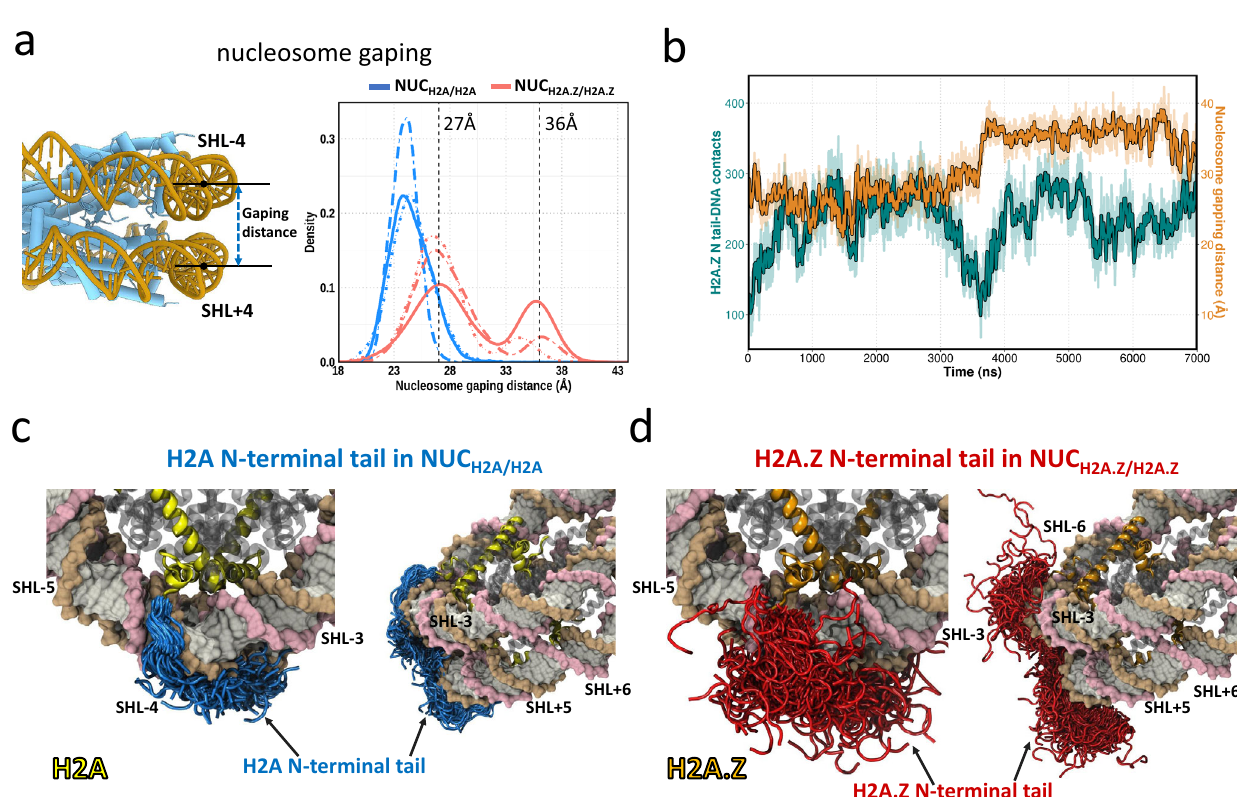
Fig.4|H2A.ZN-terminaltailmodulatesnucleosomegapping.a Distributionsof nucleosome gaping distances in NUC H2A/H2A (blue) and NUC H2A.Z/H2A.Z (red) sys- tems from three independent simulation runs (solid, dotted and dashed lines). Vertical dashed lines indicate the gaping distances at SHL±2 in the presence of SWR1 during the DNA translocation 50 . b A representative simulation run shows the timeevolutionoftheH2A.ZN-terminaltail — DNAcontacts(green)andnucleosome